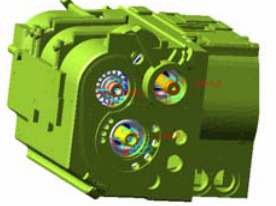
Fig.10. Dynamic model of bearing-shaft system